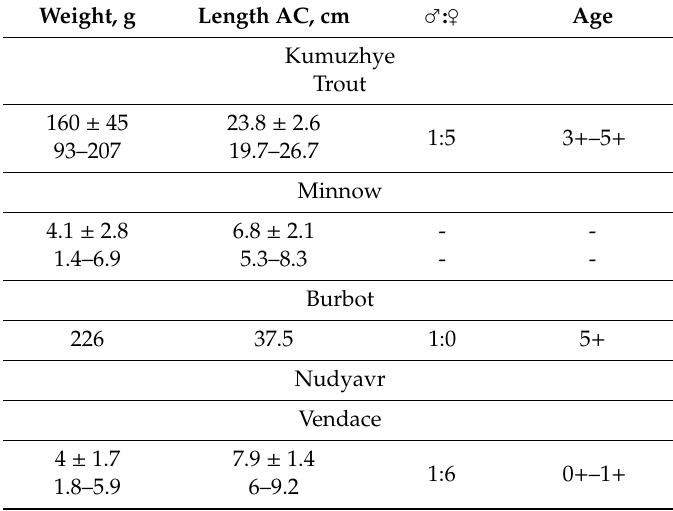
Table 3. The main biological parameters of fish in the lakes